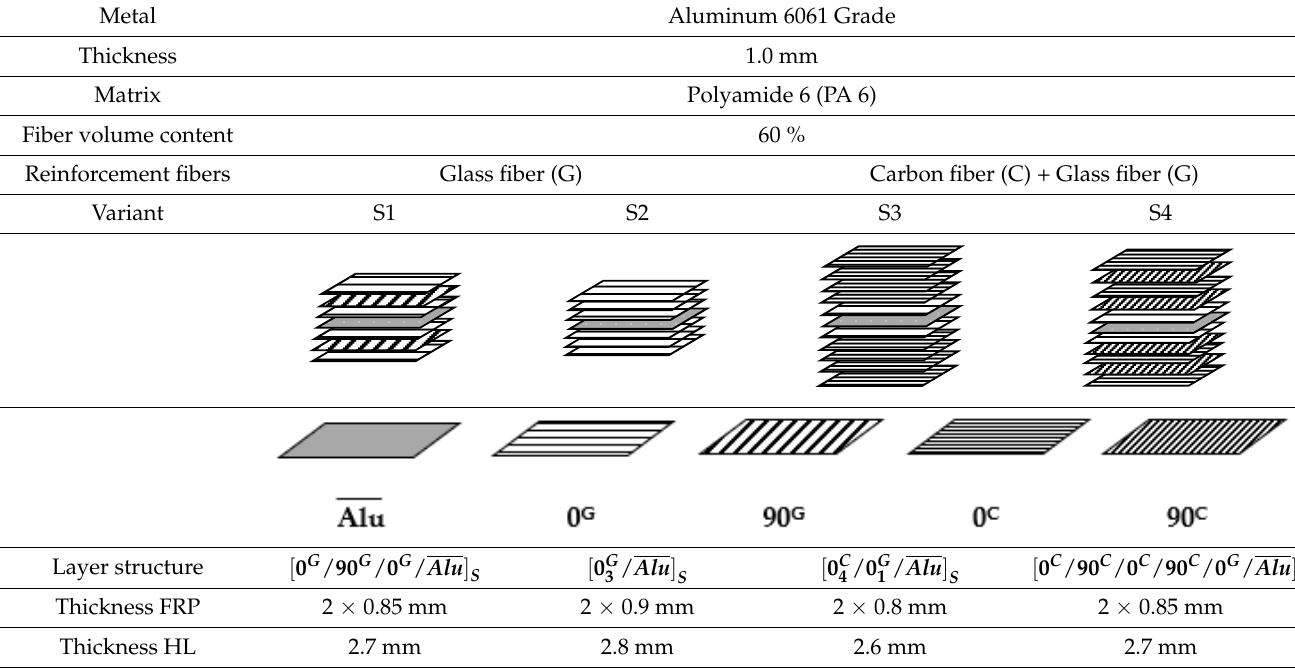
Three-point bending test (Figure 1a) was performed according to DIN EN ISO 14125 using Universal Testing Machine Zwick Z100 with a traverse rate of 0.5 mm/min. Five flat specimens for each specification (variant S1–S4, see Table 1) and fiber direction (longitu- dinal and perpendicular to the main axis of samples) were used with the dimensions pre- sented in Figure 1b. The flat samples were prepared and tested in two perpendicular di- rections, a longitudinal direction (0°) parallel to the main axis of the sample and a trans- verse direction (90°) perpendicular to the main specimen axis.